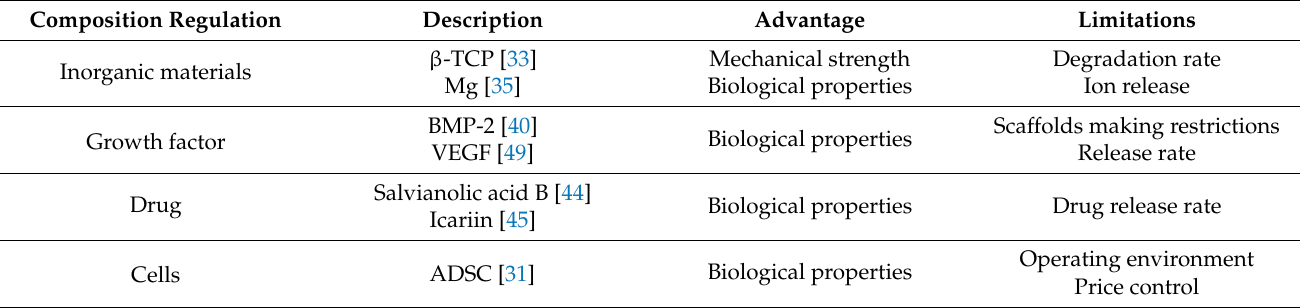
Table 1. Representative component regulation characteristics of PLGA-based scaffolds.